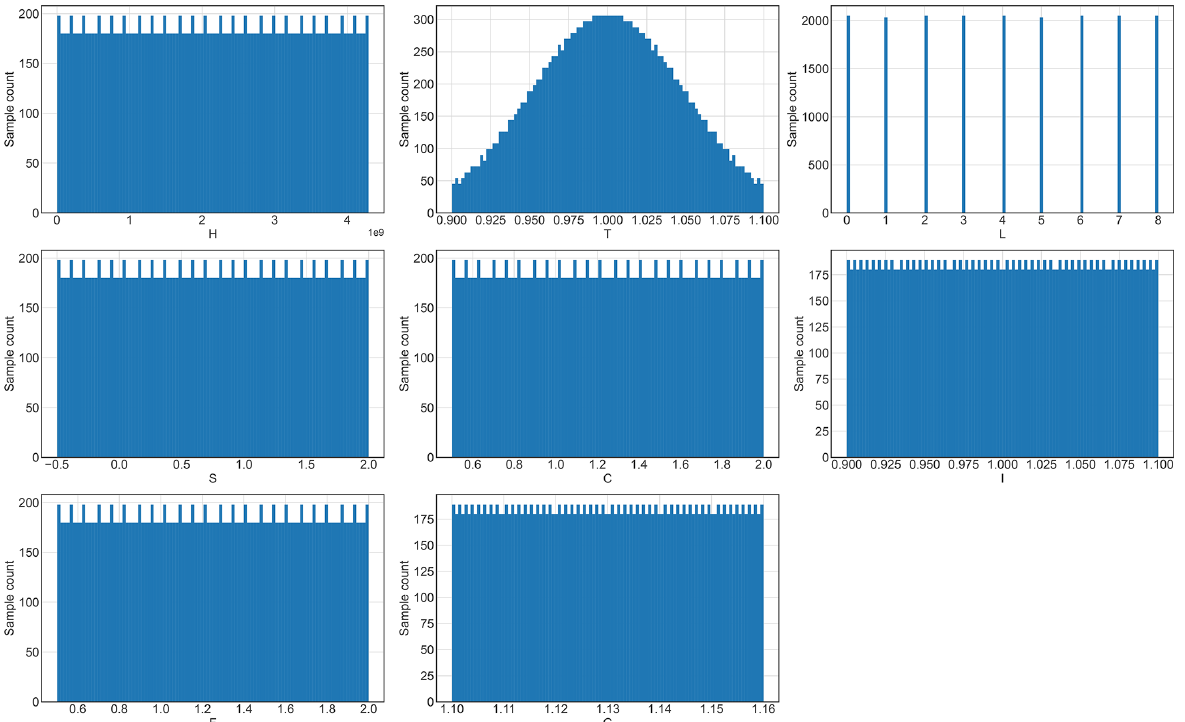
Figure D4. Samples for the uncertainty analysis of the adaptation options appraisal in Sect. 3.2.2 for the input parameters drawn from the distributions described in Table 1 using the Sobol (cid:48) sequence. The input parameters are H : hazard events bootstrapping, T : total population, L : population distribution, S : impact function intensity threshold shift, C : cost of adaptation options, I : hazard intensity change, F : hazard frequency change, and G : population growth.